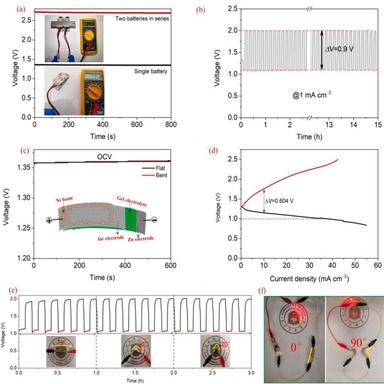
(a) OCV curves of single and two serial ZABs (the insets show the digital images); (b) Discharge/charge cycling performance of button-like ZAB at 1 mA cm−2; (c) OCV plots of the flat and bent foldable ZABs (inset: schematic representation); (d) The discharge and charge polarization curves of a foldable ZAB; (e) Galvanostatic charge/discharge cycling tests (up) and corresponding photographs (bottom) of foldable ZABs under various bending angles every 1 h at 1 mA cm−2; (f) Photographs of an lighted red LED po